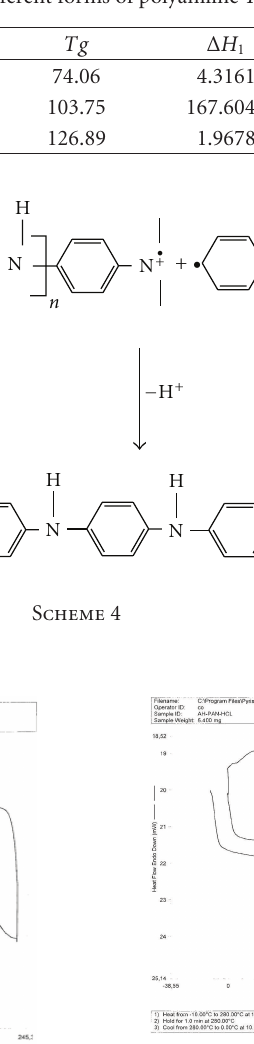
Table 2: Thermodynamics properties of di ff erent forms of polyaniline T ( ◦ C), Δ H ( J/g ), Δ Cp ( J/g ∗ ◦ C).